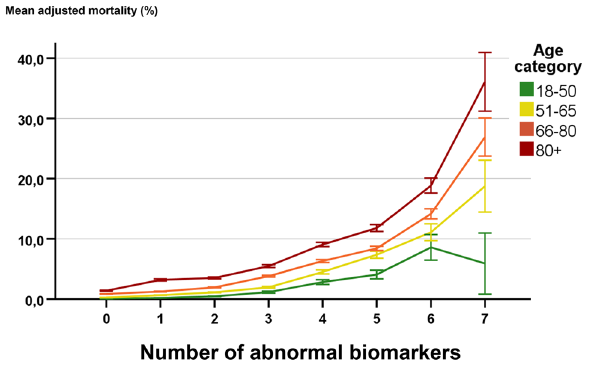
Figure 3. The association between the number of abnormal biomarkers (outside of the commonly used reference ranges) and mortality in different age categories. Mortality is shown as mean predicted mortality risk in percent (between 0 and